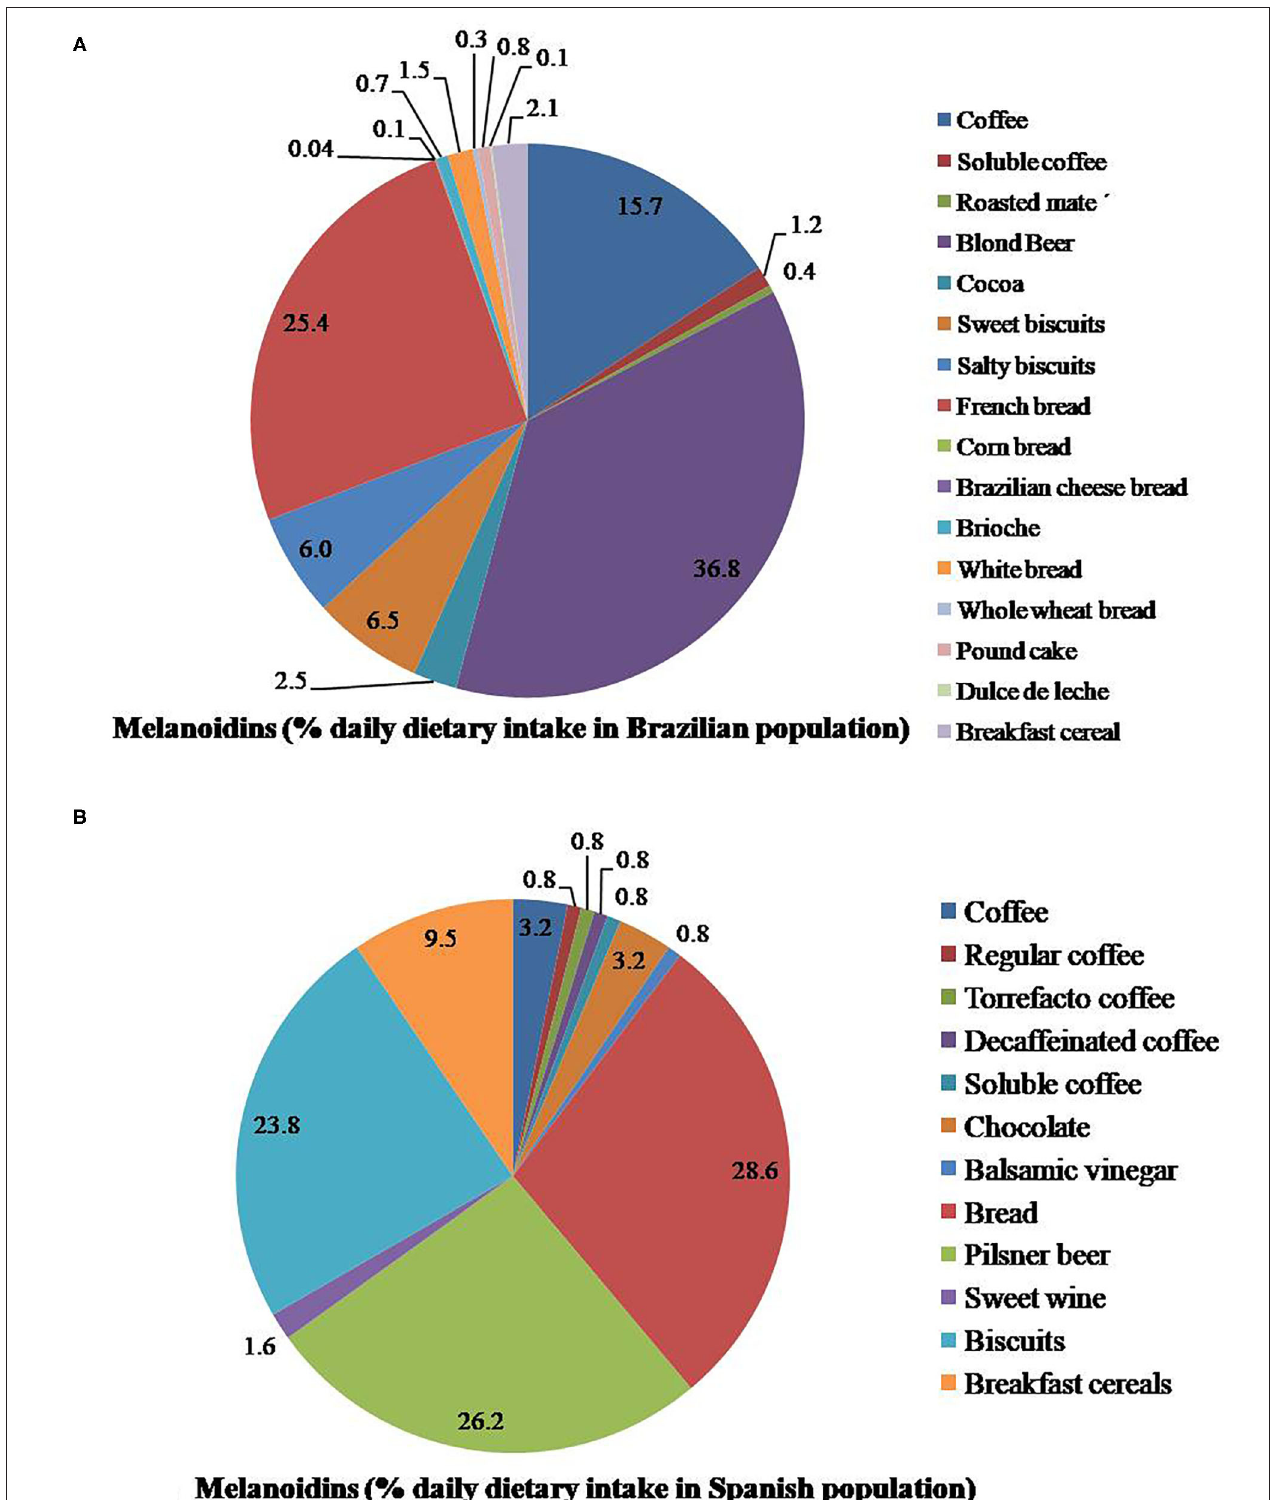
FIGURE 1 | Percentage source of dietary consumption of melanoidins in the (A) Brazilian population, (B) Spanish population (18, 19).